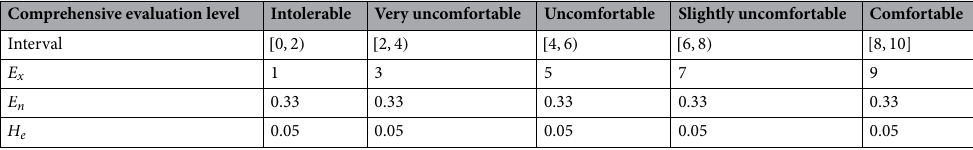
Table 2. Standard evaluation level numerical